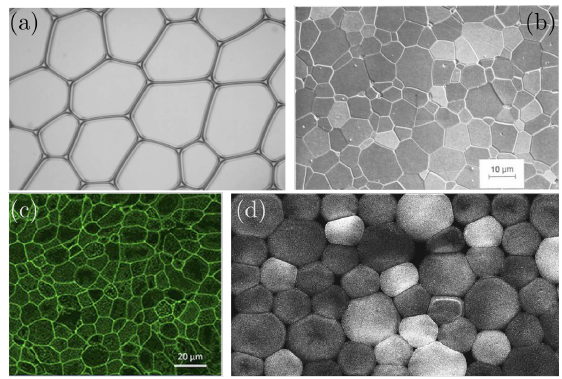
Figure 1: Squishy granular systems. (a) Highly de- formed 2D soap bubbles from [14]. (b) Sintered ce- ramic from [15]. (c) Jammed layer of biologic cells from [16]. (d) Plastic particles made of agar gel deep in the jammed state from